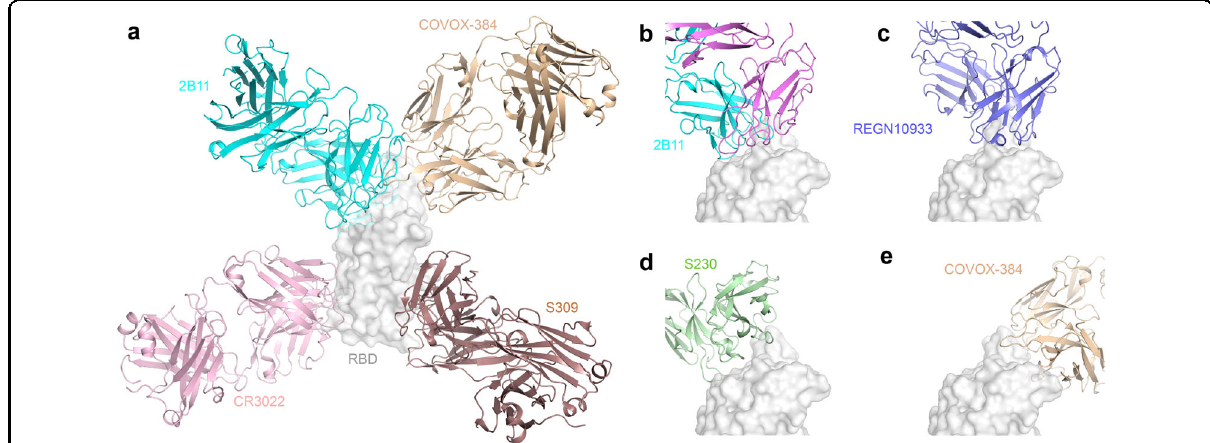
Fig. 6 Comparison of the complexes between RBD and the 2B11-Fab, or other different IGHV germline-derived neutralizing antibodies. a The 2B11, S309, CR3022, and COVOX-384 mAbs recognize different RBD epitopes. The RBD is shown in gray; 2B11, S309, CR3022, and COVOX-384 are shown in cyan, brown, pink and malt, respectively. b – e The 2B11 ( b ), REGN10933 ( c ), S230 ( d ), and COVOX-384 ( e ) bind to different sites of the RBD